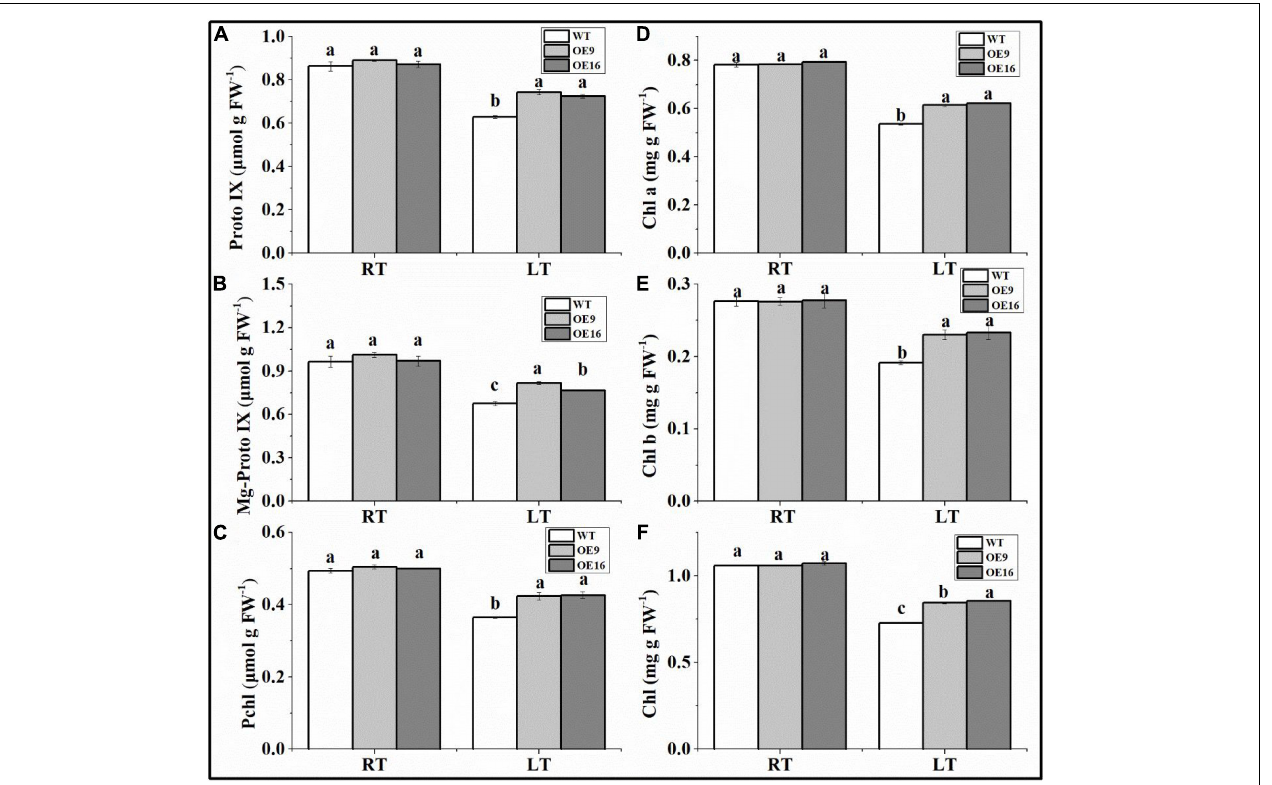
FIGURE 8 | The contents of Proto IX (A) , Mg-proto IX (B) , Pchl (C) , Chl a (D) , Chl b (E) , and total Chl (F) in the wild-type (WT) and transgenic plants exposed to 4 ◦ C for 7 day (LT). OE: the CaALAD -overexpressing (OE) lines. The error bars represent the standard errors for three independent tests. Different letters show significant differences ( p < 0.05) based on Duncan’s test.